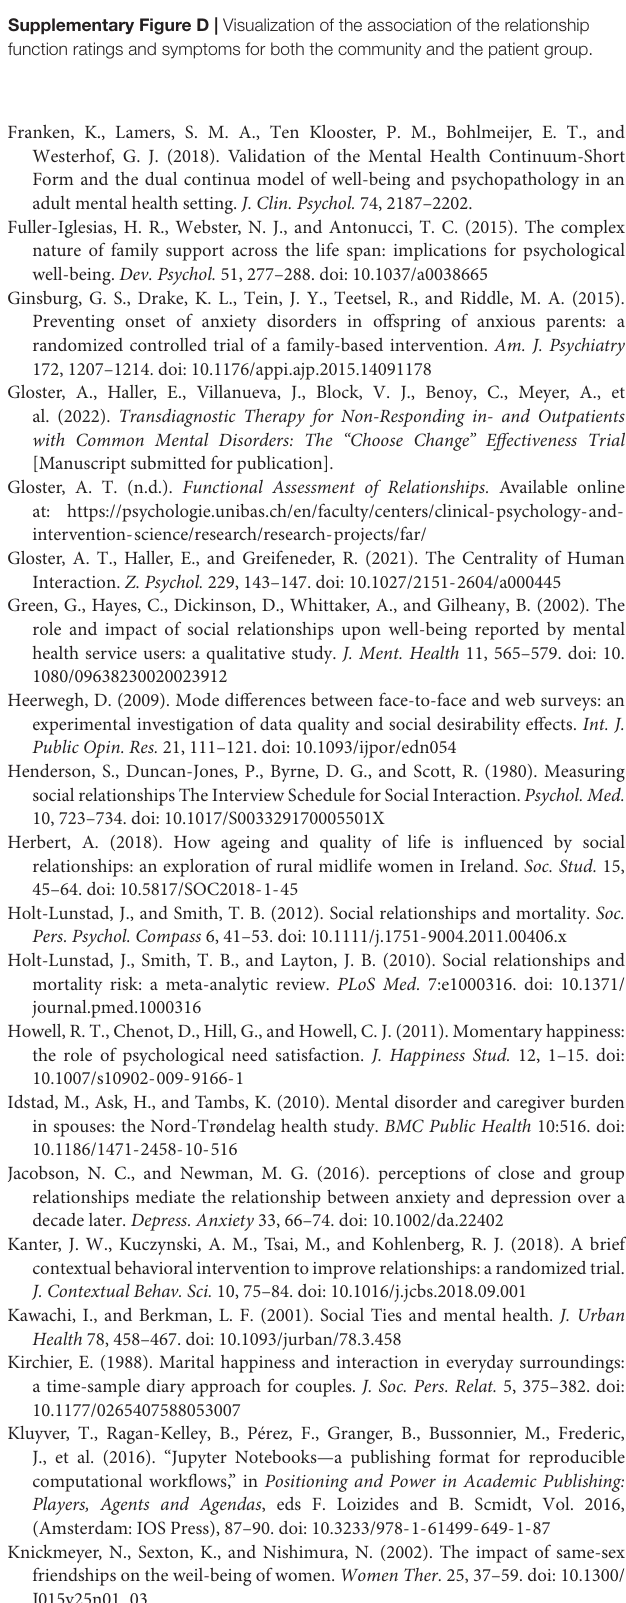
Supplementary Figure D | Visualization of the association of the relationship function ratings and symptoms for both the community and the patient